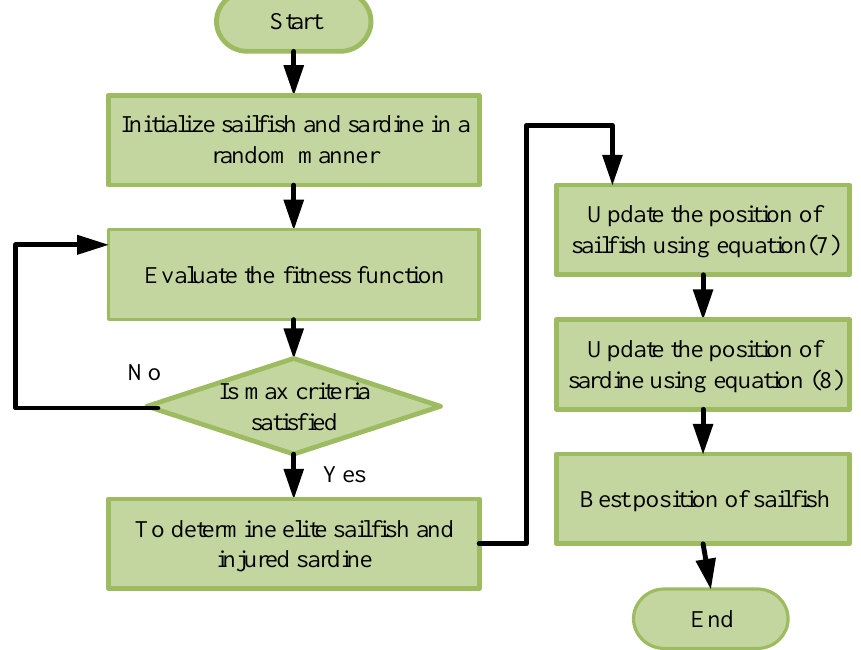
Figure 3. Flow chart of sailfish optimization.